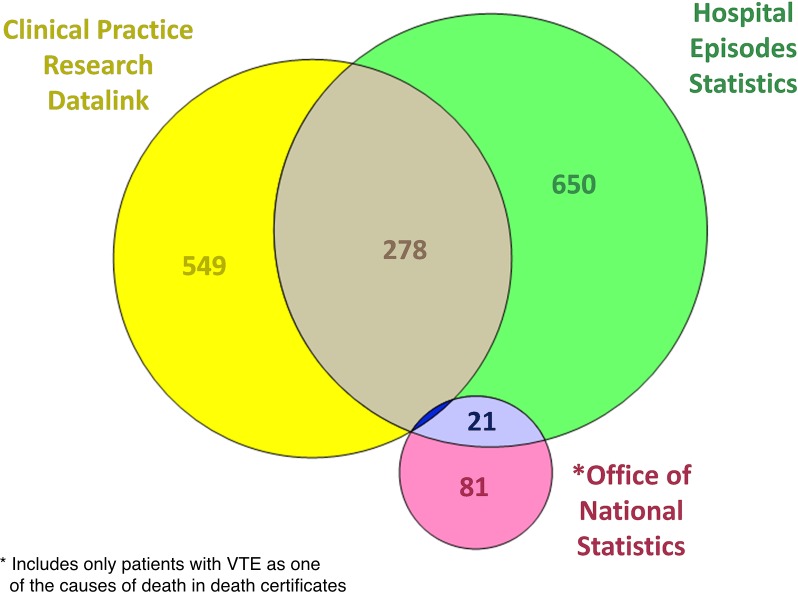
Venn diagram of VTE events according to recorded database showing overlap between databases in general surgical procedures performed between 1 April 1997 and 31 March 2012.